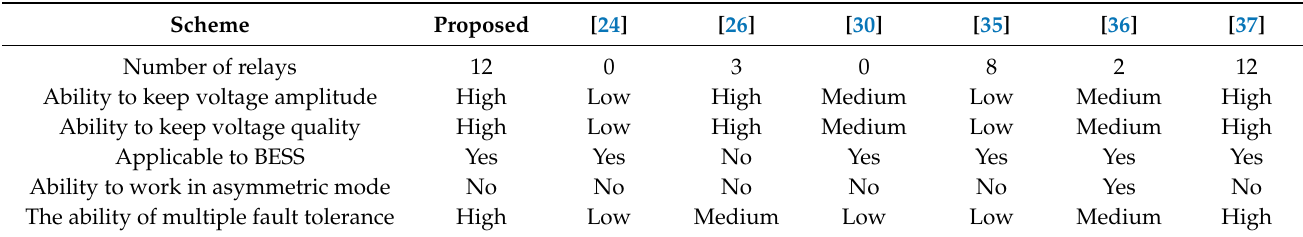
Table 6. Comparison of fault-tolerant